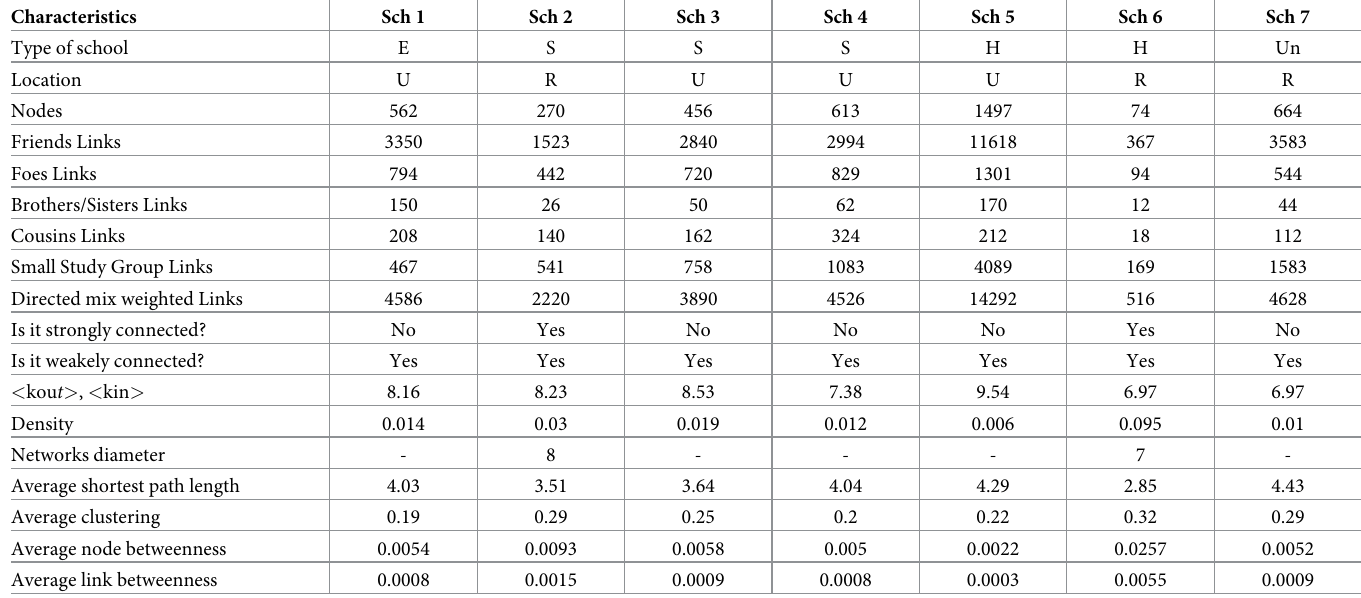
Table 2. Characteristics of school-directed networks. Networks of friendship, noncordial treatment, siblings, cousins, and study groups were characterized. Additionally, these networks were used to build the weighted network employed on the simulations. The type of school could be E lementary/ S econdary/ H igh School/ Un iversity. Addi- tionally, it can be located in an U rban area or a R ural